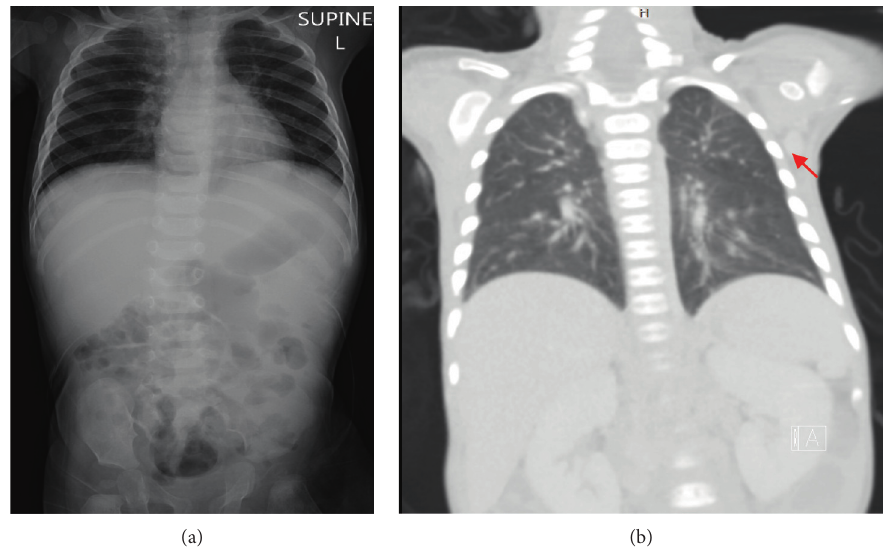
Figure 1: Panel A (4½ months of age): chest radiograph showing bilateral lung infiltrates and absent thymic shadow. Panel B (5 months of age): chest CT scan showing enlarged left axillary lymph node, measuring about 2cm in diameter